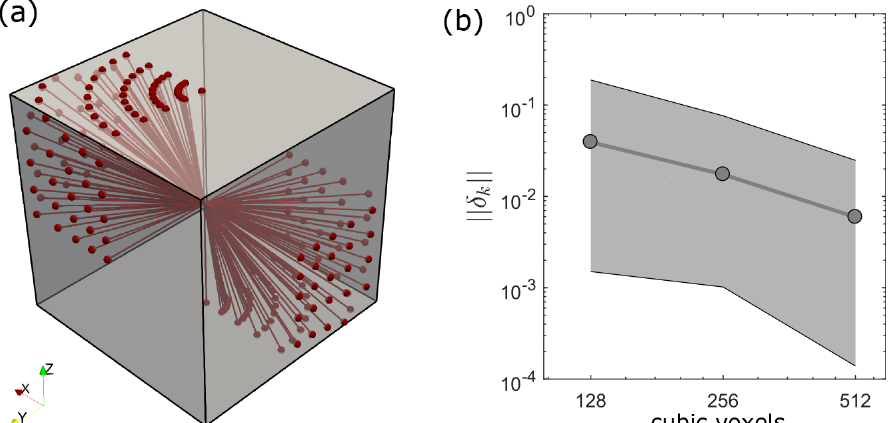
Figure 5. Panel (a) displays the location of all 100 intersection lineaments considered in the flow benchmark. A total of 52 intersection configurations directly connect inlets and outlets of flow (upper and lower z face), whereas 48 connect non-boundary flow faces. Panel (b) compares the numerically estimated permeability at highest resolution (1024 3 voxels) to the ones obtained at lower resolutions by calculating their error norms || δ k || according to Eq. (15). Gray dots represent the average error norm for all considered intersection configurations at resolutions lower than 1024 3 voxels, and the light gray area highlights the range between minimum and maximum error.